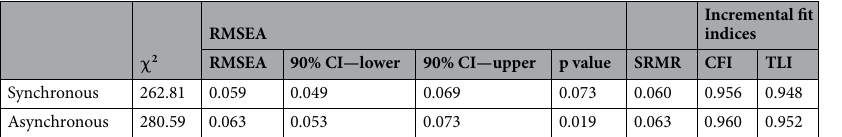
Table 3. Fit indices of the CFA are reported for both the synchronous and asynchronous conditions. All indices support the tested solution with three factors.